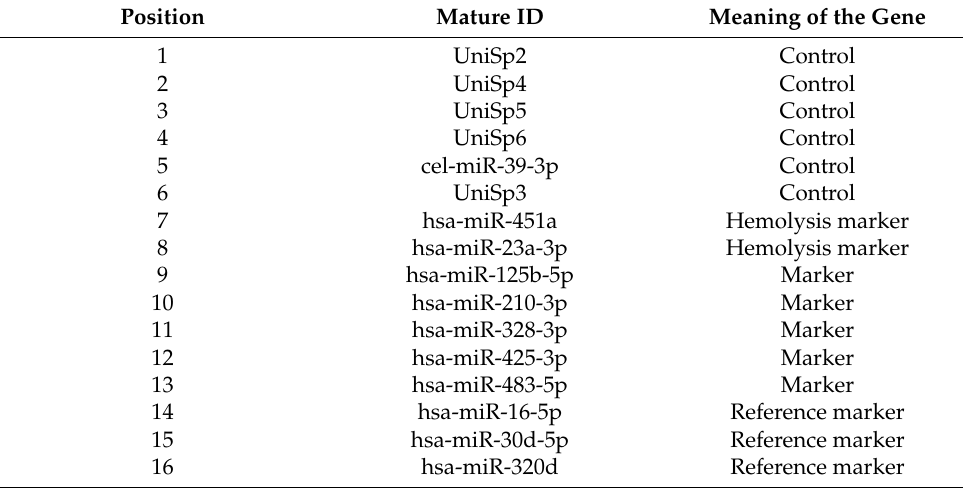
Table 8. Genes analyzed on the Custom